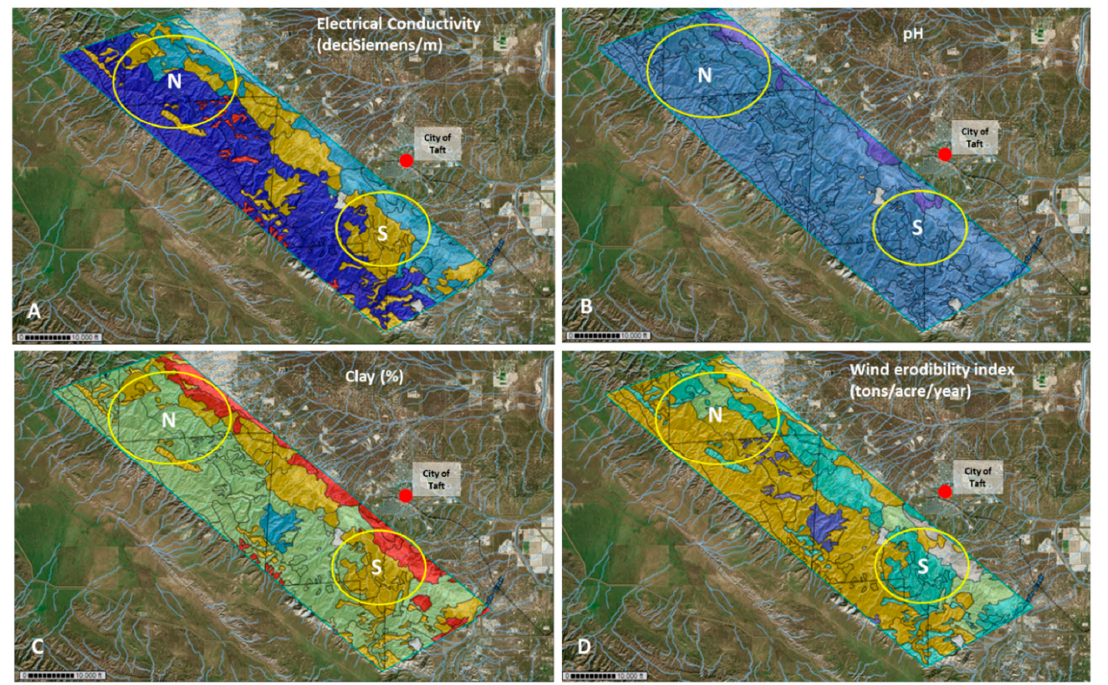
Figure 3. ( A ) Soil electrical conductivity (EC) (deciSiemens/m): 2.6 (dark blue), 2 (light blue), 1.2 (light green), 1 (yellow), 0–0.5 (red). ( B ) Soil pH: 8.6 (dark blue), 7.9–8.2 (blue). ( C ) Percent clay: 21.5 (light blue,) 16.3–18 (light green), 11.3–12 (red), 13.0 (yellow). ( D ) Wind erodibility index (Rating tons per acre per year): 86 (yellow and light green), 56 (turquoise), 38 (dark blue). The southern and northern sampling area are indicated by a yellow circle (S and N). The city of Taft is indicated by a red circle east of the Temblor SRMA.